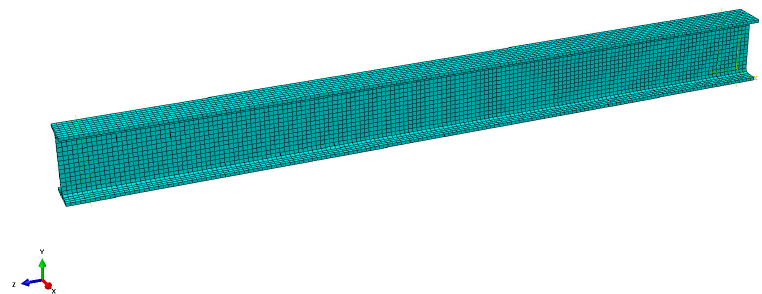
Figure 15. Load–strain curves of the flange: ( a ) Test beam A01; ( b ) Test beam A11; ( c ) Test beam A23.